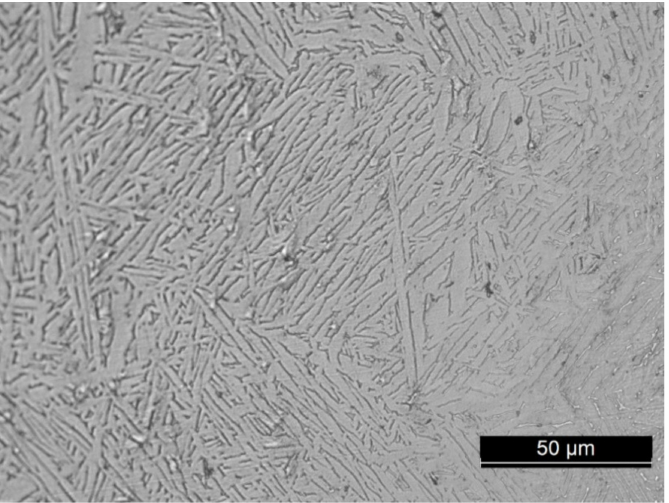
Figure 3. Microstructure of the Ti6Al4V